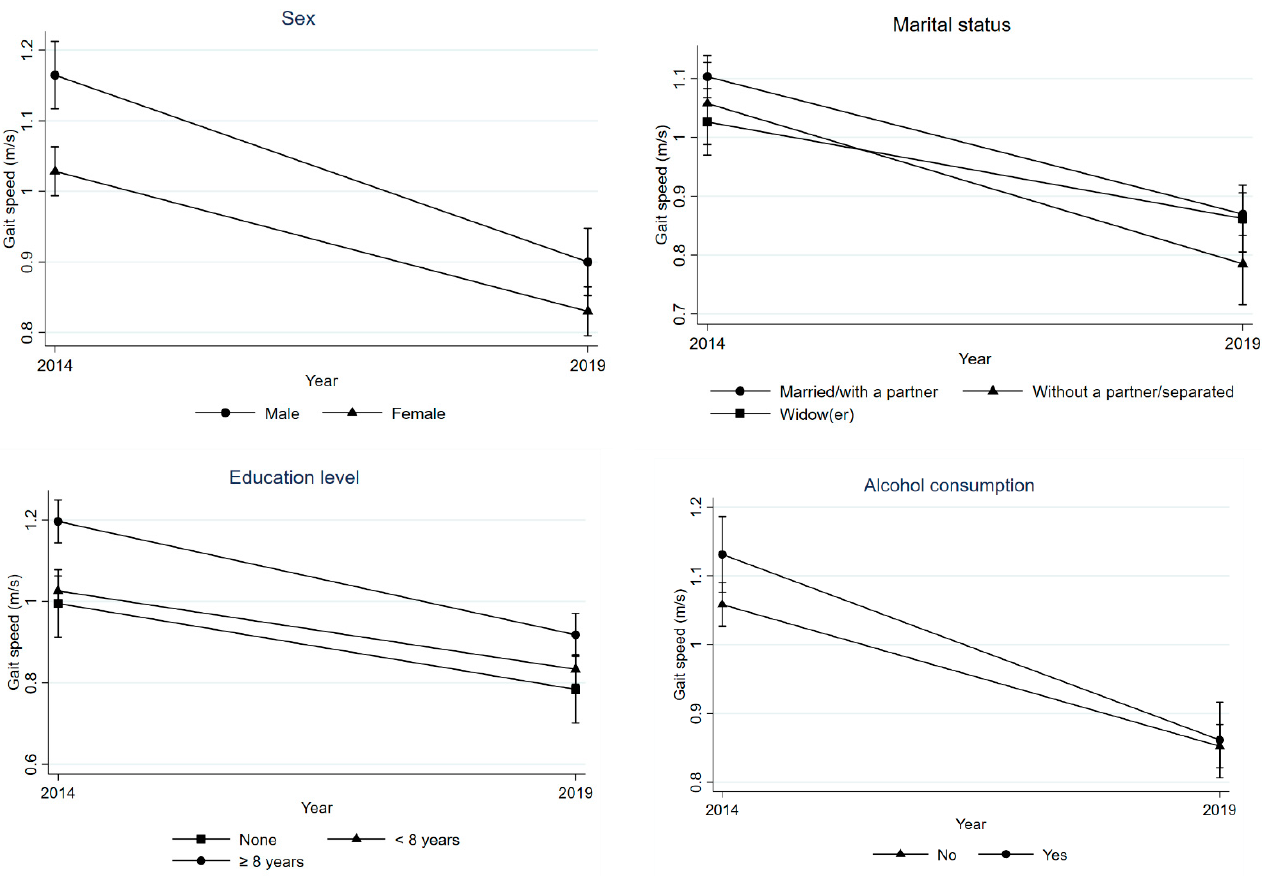
Figure 2. Difference in GS between 2014 and 2019 according to sex, marital status, education level, and alcohol consumption of individuals.